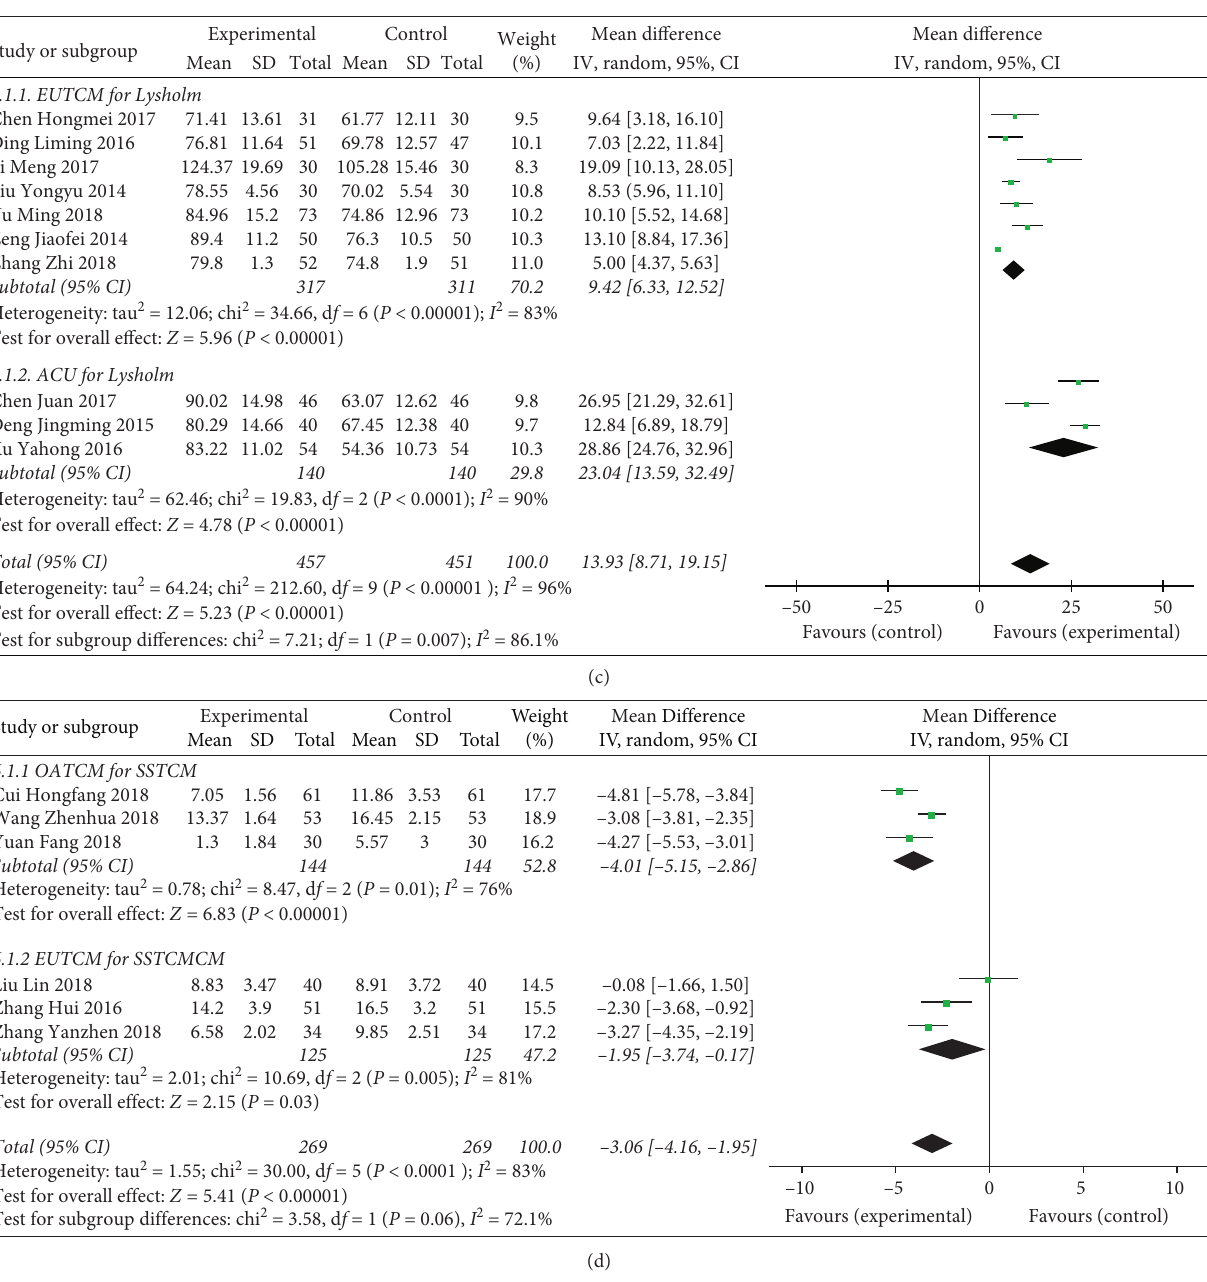
Figure 5: Forest plot of self-activity score in patients treated with TCM therapy and Western medicine therapy. (a) The plot of VAS, (b) the plot of WOMAC, (c) the plot of Lysholm, and (d) the plot of SSTCM. (I) 2 and (P) are the criteria for the heterogeneity test, ◆ : pooled mean difference, — ■ —: mean difference, and